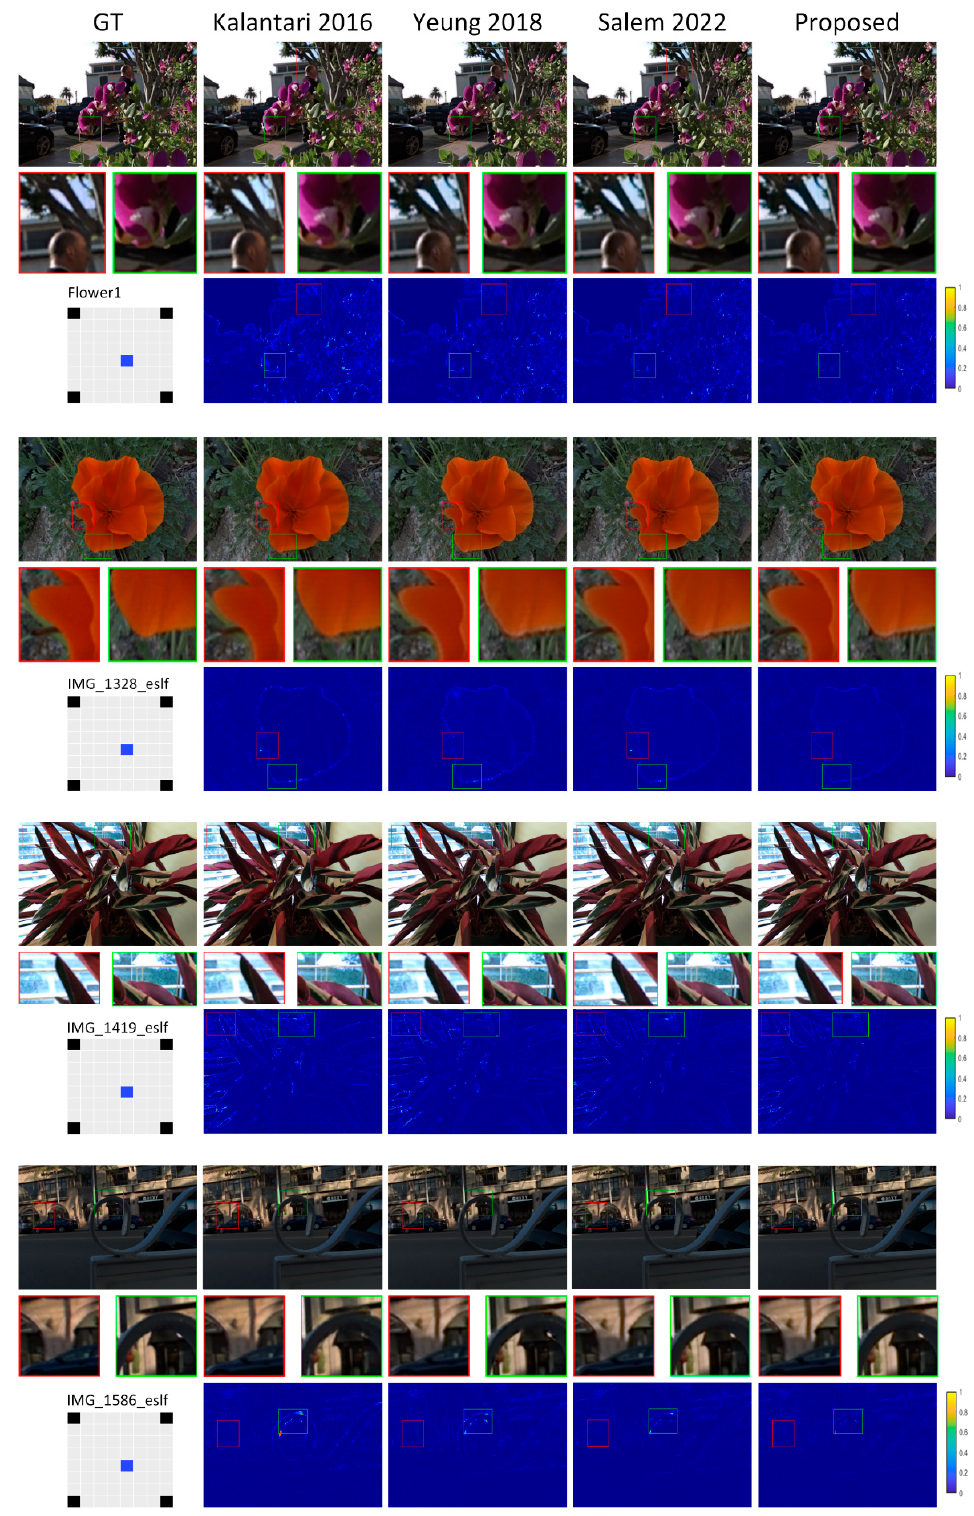
Figure 6. Visual comparison of the proposed model to reconstruct 8 × 8 views out of 2 × 2: extrapolation 0. extrapolation